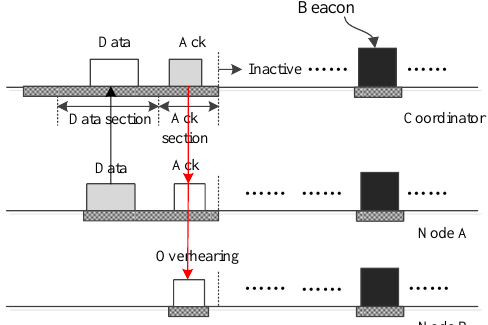
Figure 5. Only one node sends small data to the coordinator.